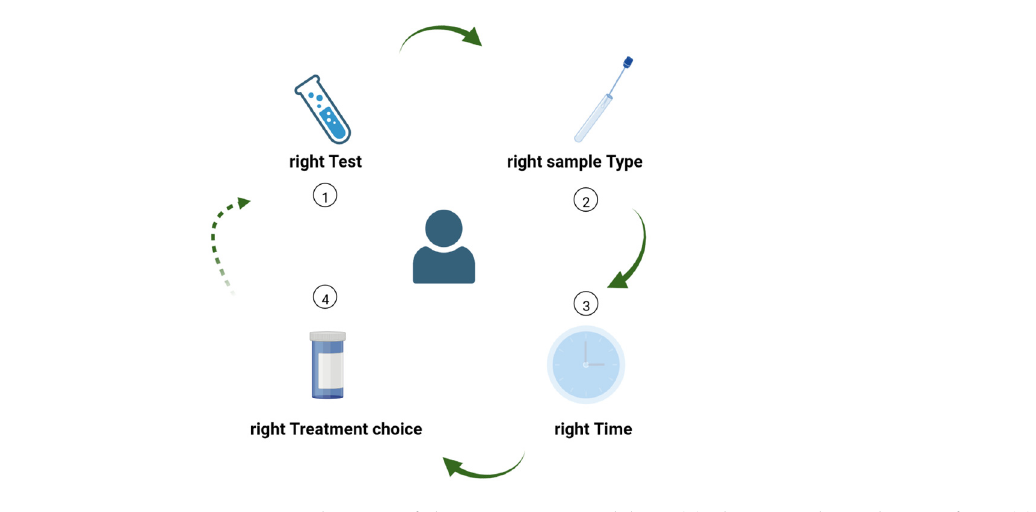
Figure 4. The 4 Ts of diagnostic stewardship: (1) choosing the right Test from (2) the right Type of sample, collected at (3) the right Time, in order to (4) guide Treatment decisions. The process can be restarted whenever a new laboratory test has the potential to further guide the diagnostic or thera- peutic process, or to better monitor the patient’s evolution under treatment.